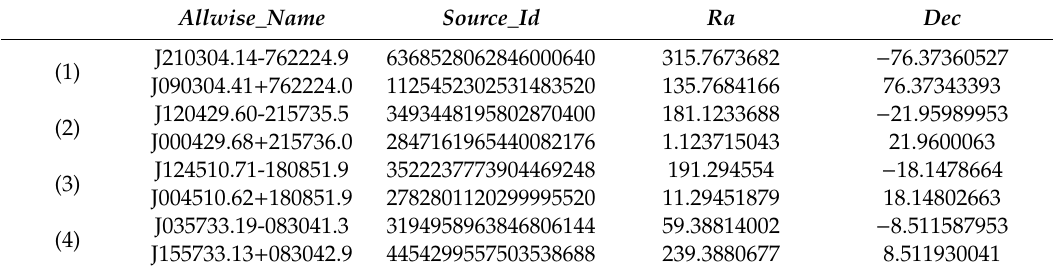
Table 11. Pairs of quasars from GAIADR2Q catalog for mirror and lens e ff ects. Source_id—the unique identification number in GAIA DR2 database. Accuracy is of 0.0005 ◦ for ra and dec . Redshift z is